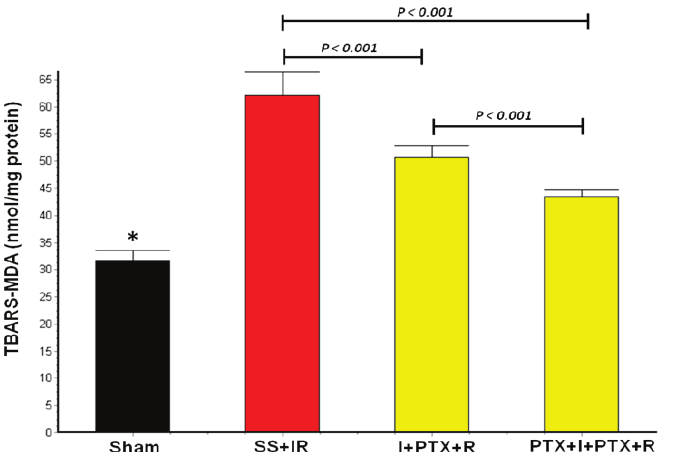
FIGURE 4 - Effect of pentoxifylline treatment on the tumor necrosis factor (TNF)-alpha content in rat lung homogenates. Groups are as in the legend to Figure 1. Data are mean ± SD. * P <0.001 regarding all other